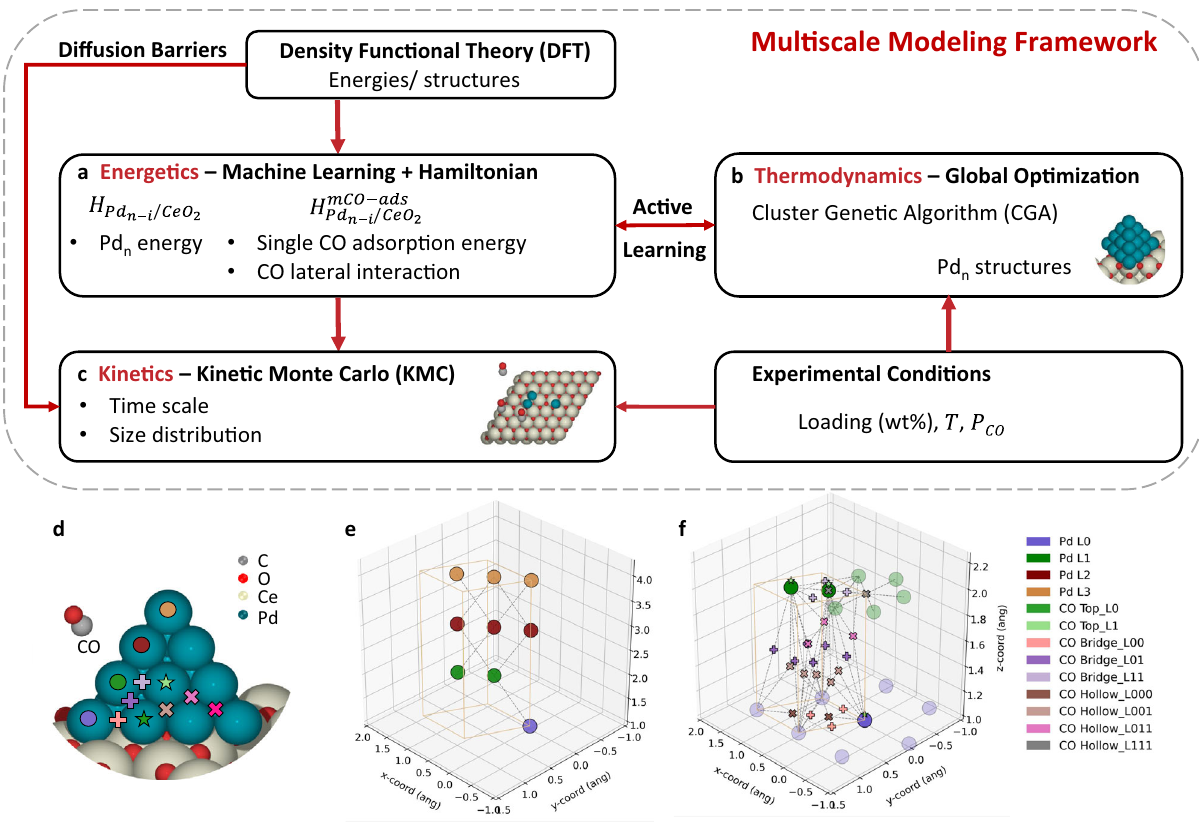
Fig. 1 Multiscale modeling framework for subnanometer catalysts. a Machine-learning-based Hamiltonians via cluster expansion for the bare metal (Pd) clusters and adsorbate (CO). The scheme is iterated until convergence using active learning. b Monte-Carlo-based structure optimizations: bare clusters (CGA-Metropolis). c Kinetic Monte Carlo (KMC) simulations for cluster dynamics. Color code: gray, C; red: O; light yellow, Ce; cyan, Pd. d Structure visualization of Pd 20 on CeO 2 (111). Labeled Pd sites and CO adsorption sites on a facet. Color code: gray, C; red, O; light yellow, Ce; cyan, Pd. e Lattice of the bare Pd n . Pd sites are labeled according to their distance from the support (Pd L0, L1, L2, or L3; Ln refers to the layer number with respect to its distance from the support, i.e., the base, second, third, fourth layer and so on). f Lattice of the Pd n -CO. CO adsorption sites indicate the adsorption type (top, bridge, or hollow) and the layer number of the neighboring Pd atoms, e.g., CO Top_L0 (CO on top of Pd on the layer on the support), Bridge_L01 (CO on bridge site with one Pd on L0 and one Pd on L1), Hollow_L011, and so on. The unit cell boundary is in orange and the nearest neighbor connections in dotted lines. The two-lattice representation allows very ef fi cient computations.